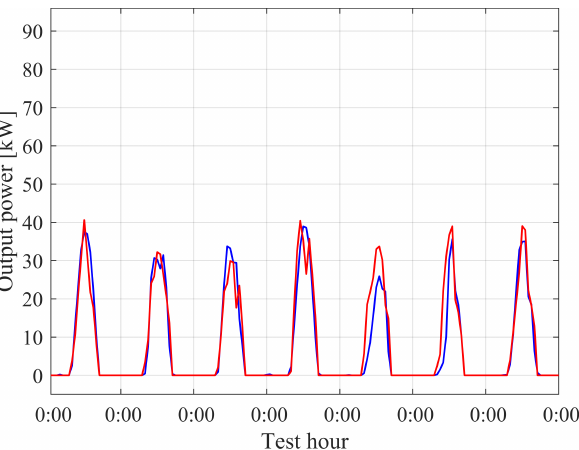
Figure 11. Predicted (red) and real (blue) value of output power in the mid of December 2018, by using the 2D-CNN approach with the univariate input on the 7-day test set (see Table 9, row 1, column 4).